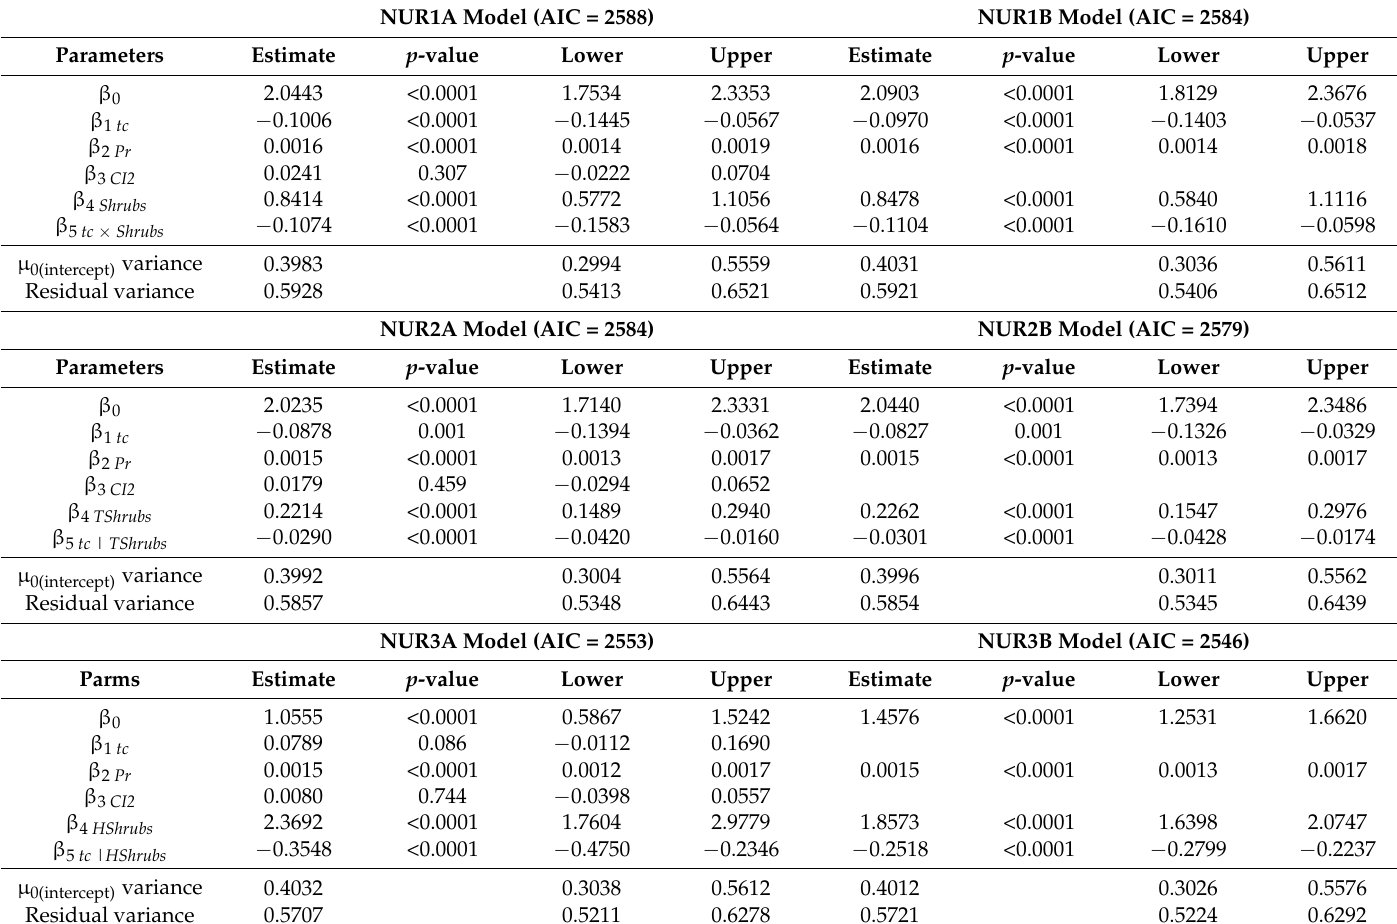
Table 4. Parameters estimates for the three alternative cork ring width (rw) models (with and without the CI variable) regarding the NUR management variables listed in Table 1 ( n = 1006), where: tc is the cork ring age (years); Pr is the annual precipitation (mm); CI2 is the number of competitors, within 20 m, with duj > dui; Shrubs is the presence of shrubs in understory observed two years after clearing; TShrubs is the time without understory removal; HShrubs estimates understory mean height (m) as a function of